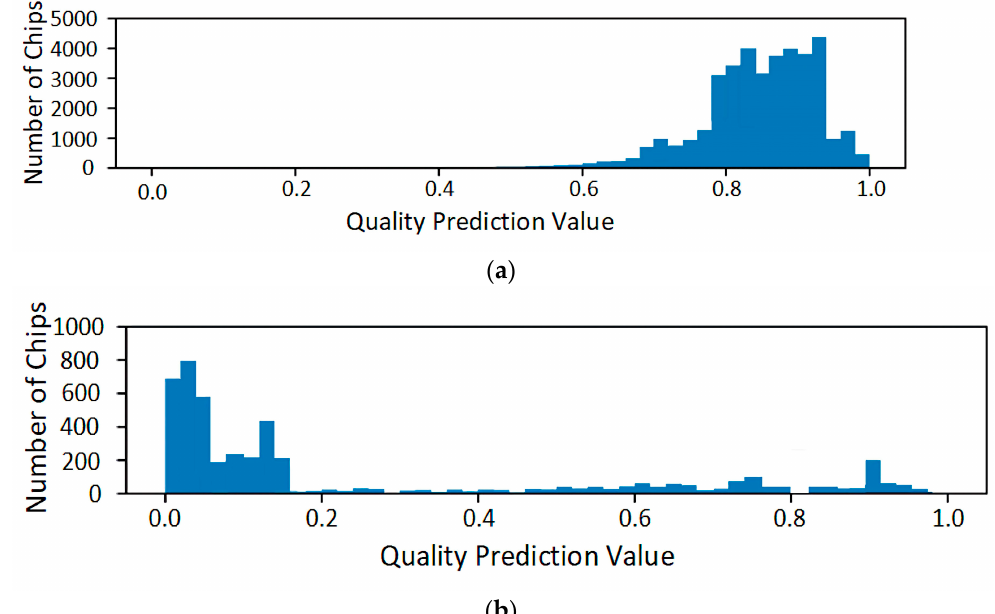
Figure 5. Relationship between predicted quality and the pass/fail status of chips. ( a ) Passed chips; ( b ) failed chips.